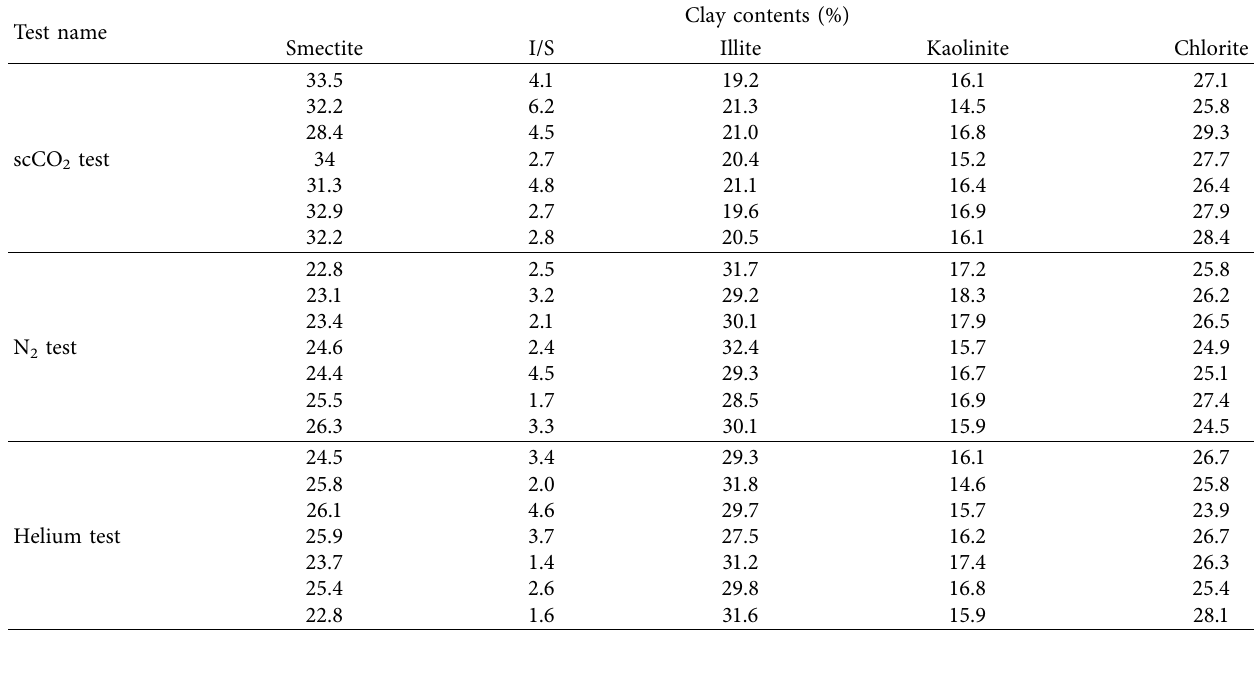
Table 5: Clay analysis results of the three experiments (XRD).